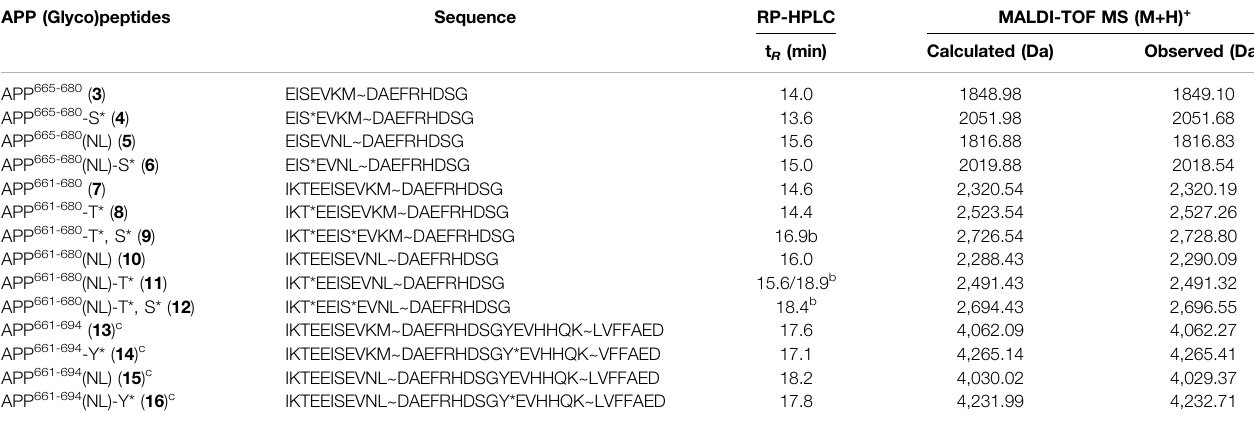
TABLE 1 | Characterization of APP (glyco)peptides 3 – 16 by analytical RP-HPLC and MALDI-MS a . APP